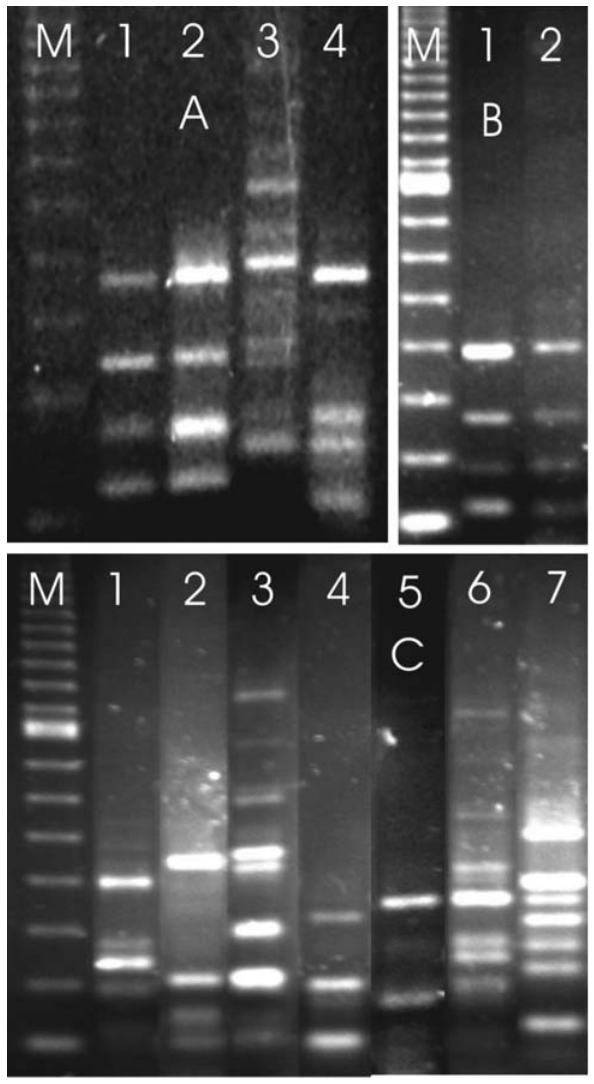
Figure2 -AmplificationproductsgeneratedbytDNA-PCR.A.lane1= P. aeruginosa PA01, lane 2 = P. aeruginosa ATCC 9027; lane 3 = P. putida ATCC 15175 and lane 4 = P. fluorescens ATCC 13525. B. Reference strains: lane 1 = P. aeruginosa PA01 and lane 2 = isolate 22 (both repre- senting the T1 amplification pattern). C. lane 1 = T2 amplification pattern (AP),lane2=T3AP,lane3=T4AP,lane4=T5AP,lane5=T6AP,lane 6 = T7 AP and lane 7 = T8 AP. Lane M = 100 bp